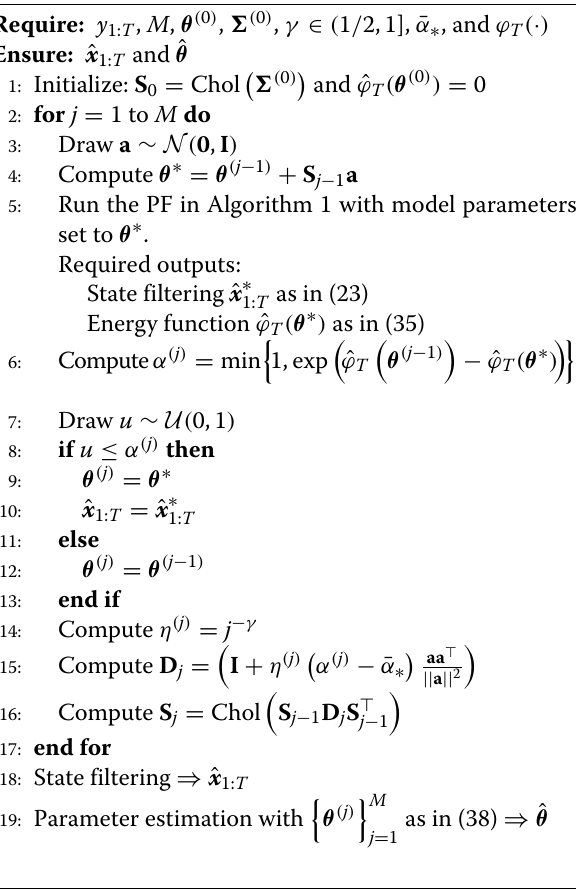
Algorithm 3 Joint state-parameter estimation by Particle Marginal